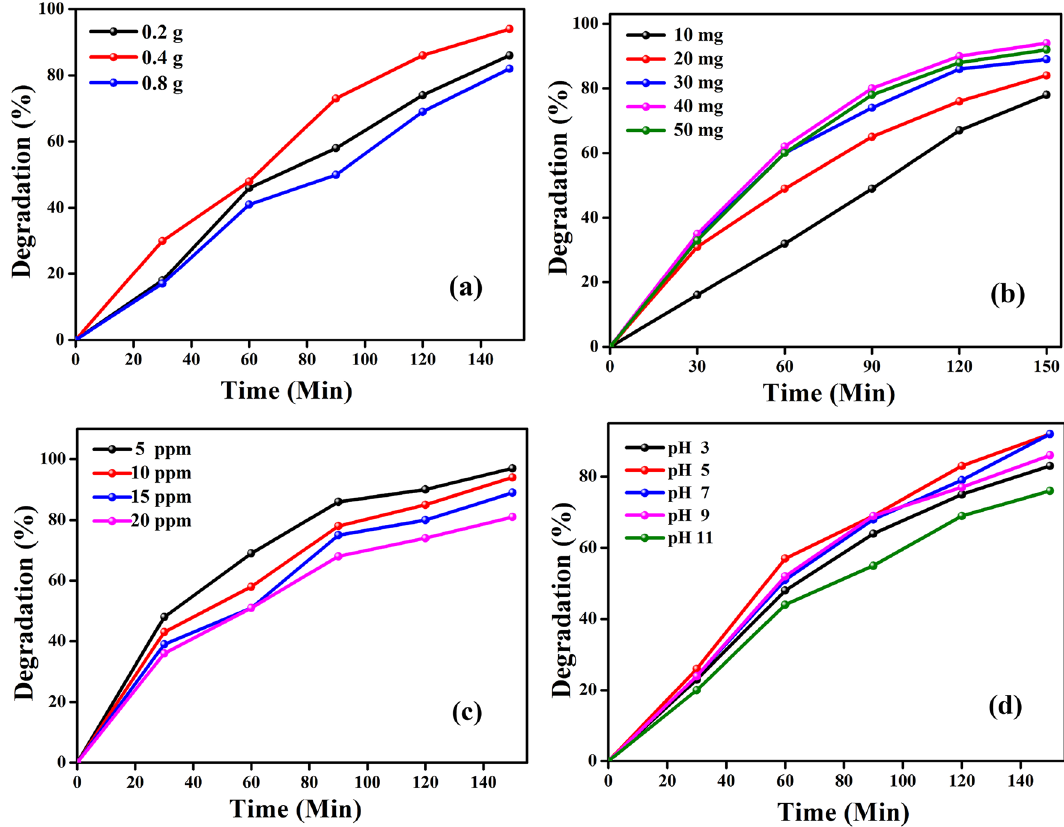
Figure 5. ( a ) Degradation plot of rose Bengal dye with 3 different fuel ratios of 3D-F-KT NPs ( b ) Photocatalytic activity at different dye concentrations using 0.4 g catalyst ( c ) Photocatalytic activity of 5 ppm RB dye with different catalytic load of KT NPs ( d ) Effect of pH on photocatalytic activity of 3D-F-KT NPs. Material Source of light